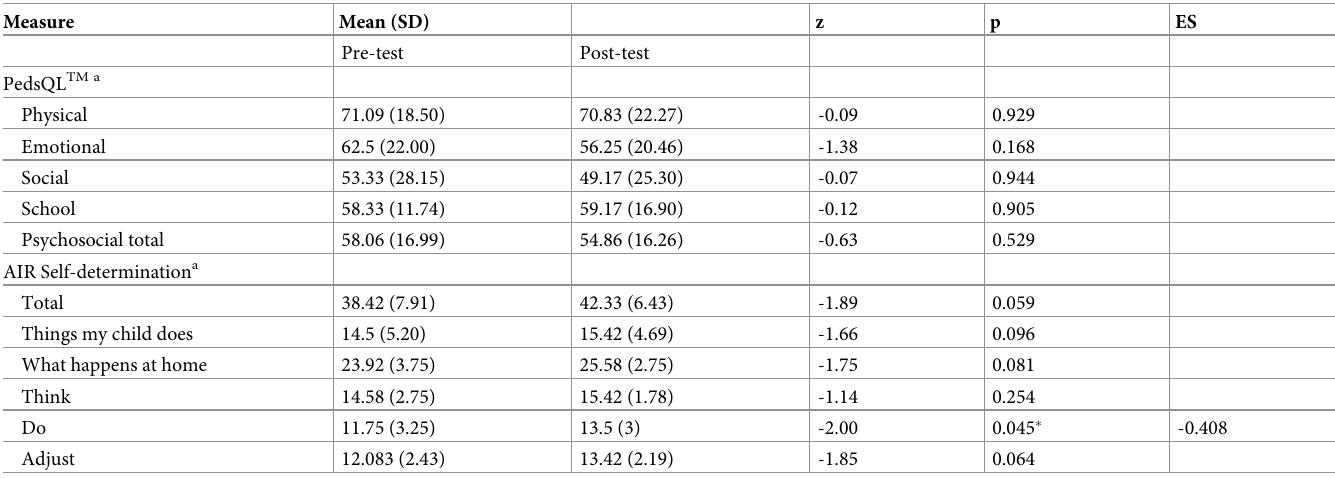
Table 7. Wilcoxon signed-rank test results of parent reported